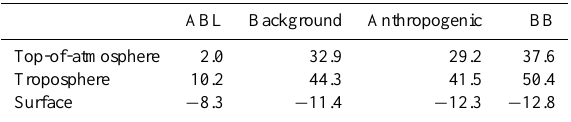
Table 4. Radiative forcing efficiency (Wm − 2 τ − 1 ), the radiative forcing per optical depth, to the top-of-atmosphere, atmosphere, and surface for the four aerosol regimes measured during